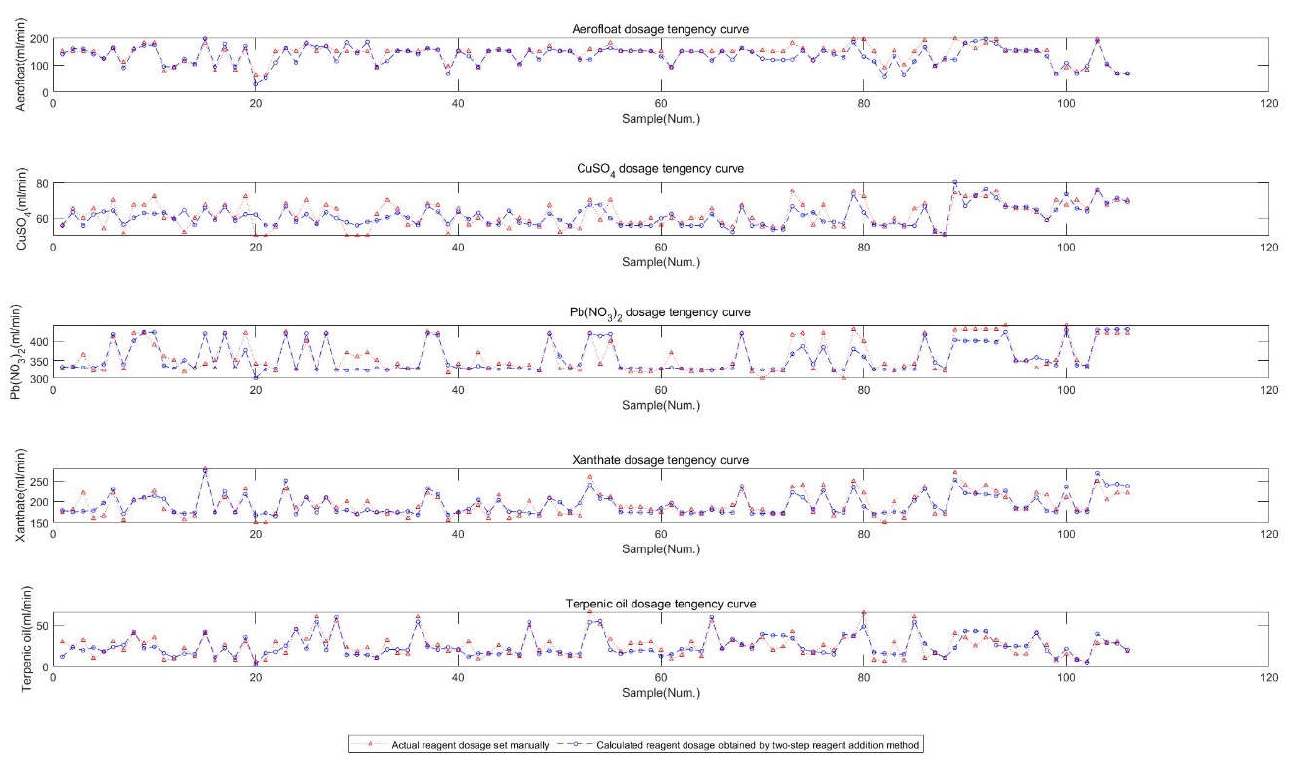
Figure 6. Comparison of the two methods for reagent dosing.